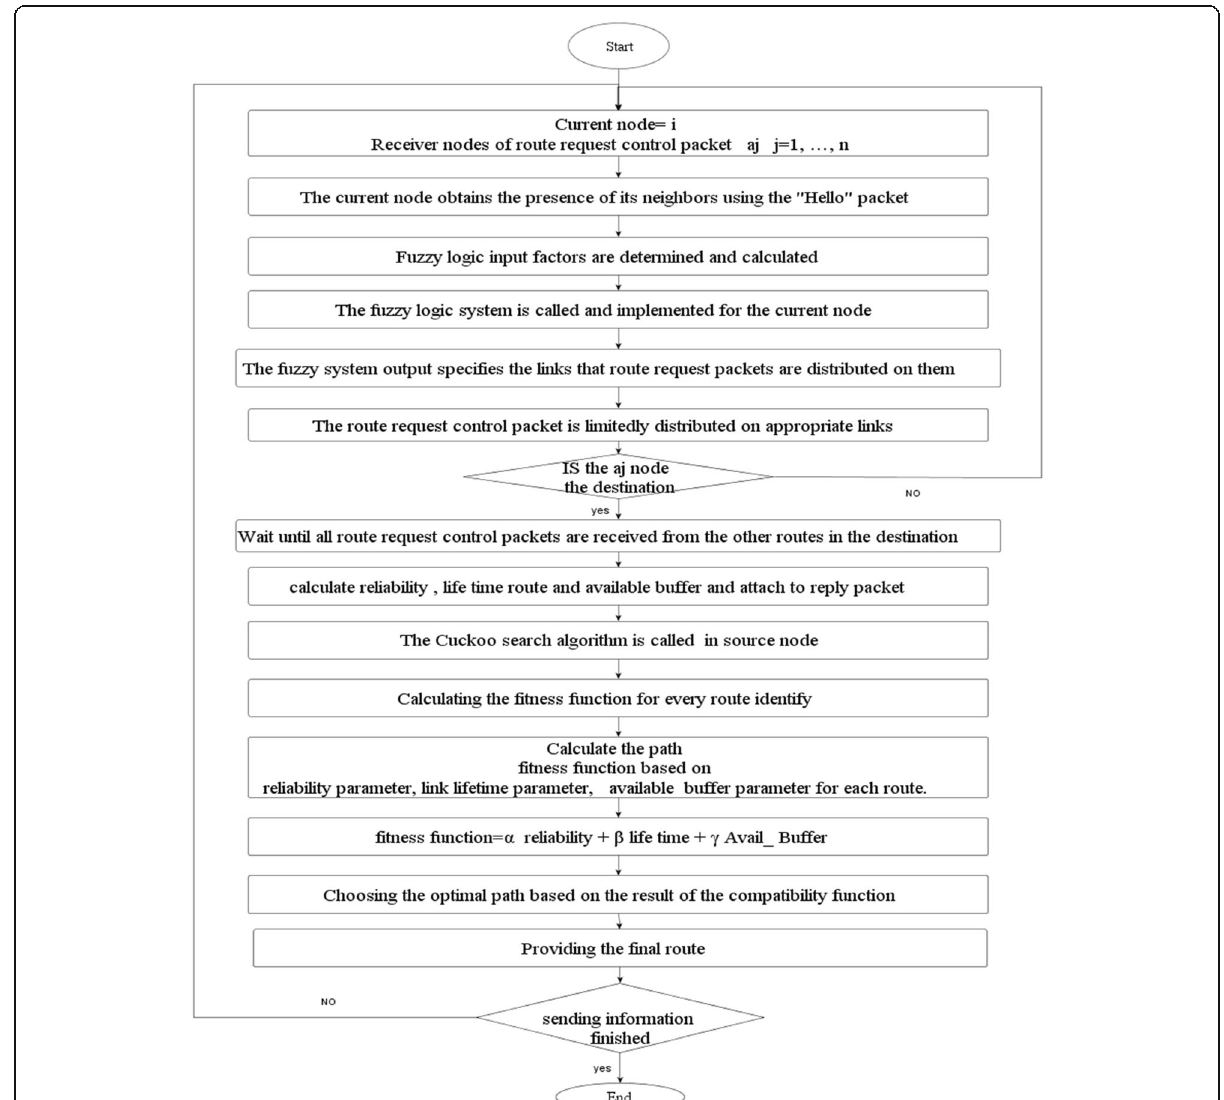
Fig. 2 Flowchart of TIHOO. The flowchart of the proposed protocol. The steps of the proposed protocol are shown in this figure in